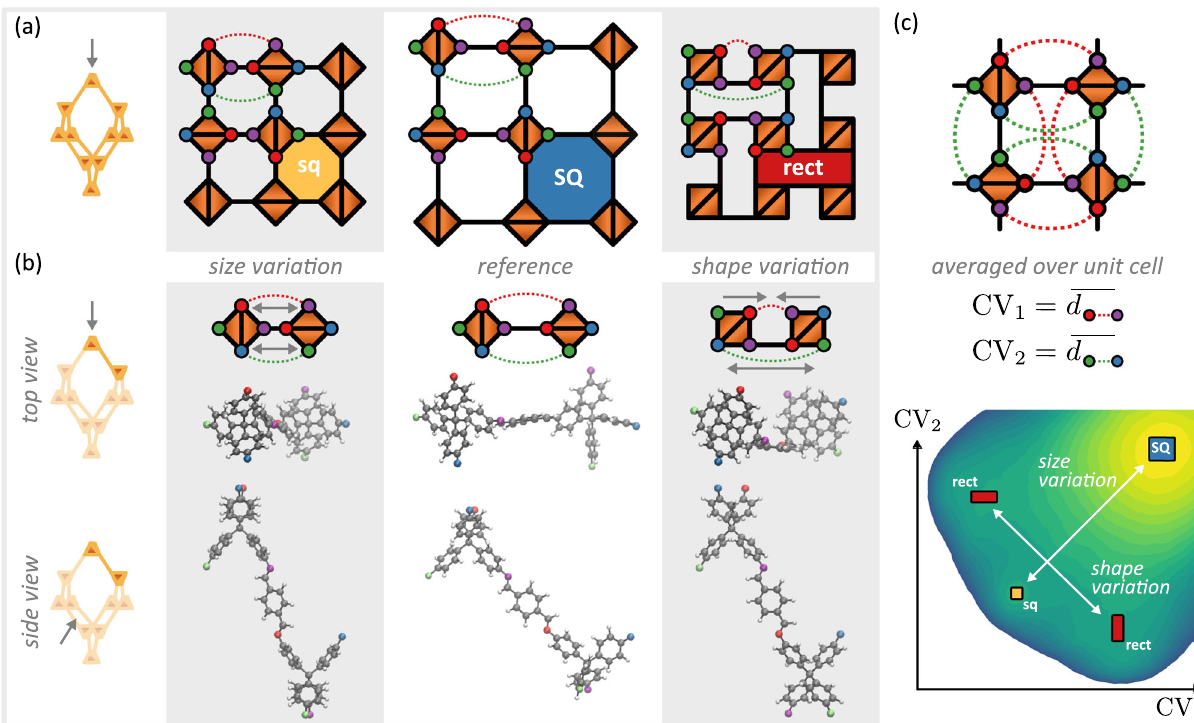
Fig. 3 De fi nition of the collective variables and the corresponding transition mechanism between the three distinct phases, SQ, sq and rect. a The distinct phases, where the points of extensions have been indicated by coloured circles, in correspondence with Fig. 1. b The variations in channel size and shape, relative to the reference, can be de fi ned via two types of distances, indicated by the red and green dotted lines. Pure size variations only occur when both distances increase or decrease simultaneously, whereas shape variations are introduced when the distances change differently. Their atomic representations, in both top and side view, for the case of COF-300, are provided to illustrate the corresponding transition mechanism. This clearly visualises that a size decrease elongates the dia cage in the [001] direction while compressing it in the perpendicular directions, while a shape change is facilitated by rotating tetratopic building blocks. c Through averaging the two types of distances in panels a and b over the unit cell, two collective variables are obtained, capable of describing the simultaneous occurrence of all phases and validating the choice of CVs, as demonstrated in the free energy surface for fourfold interpenetrated